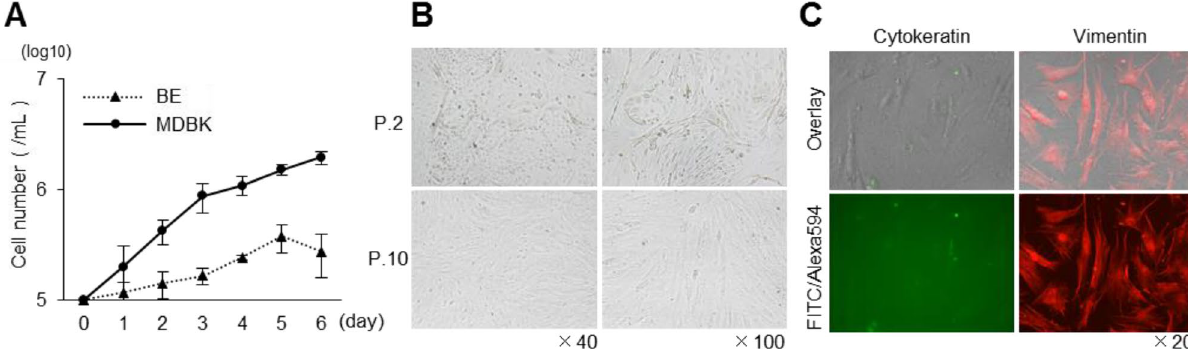
Figure 2. Characterisation of BE cells. ( A ) The growth kinetics of BE cells (P.20) were compared with those of MDBK cells. Both cell types were seeded at a concentration of 1 × 10 5 cells/well, and the number of cells was counted every 24 h for 6 days. ( B ) BE cells pictured from P.2 and P.10. ( C ) IFA, using anti-cytokeratin and anti- vimentin antibodies, was performed to investigate the constituent cells in the BE cells (P.10).